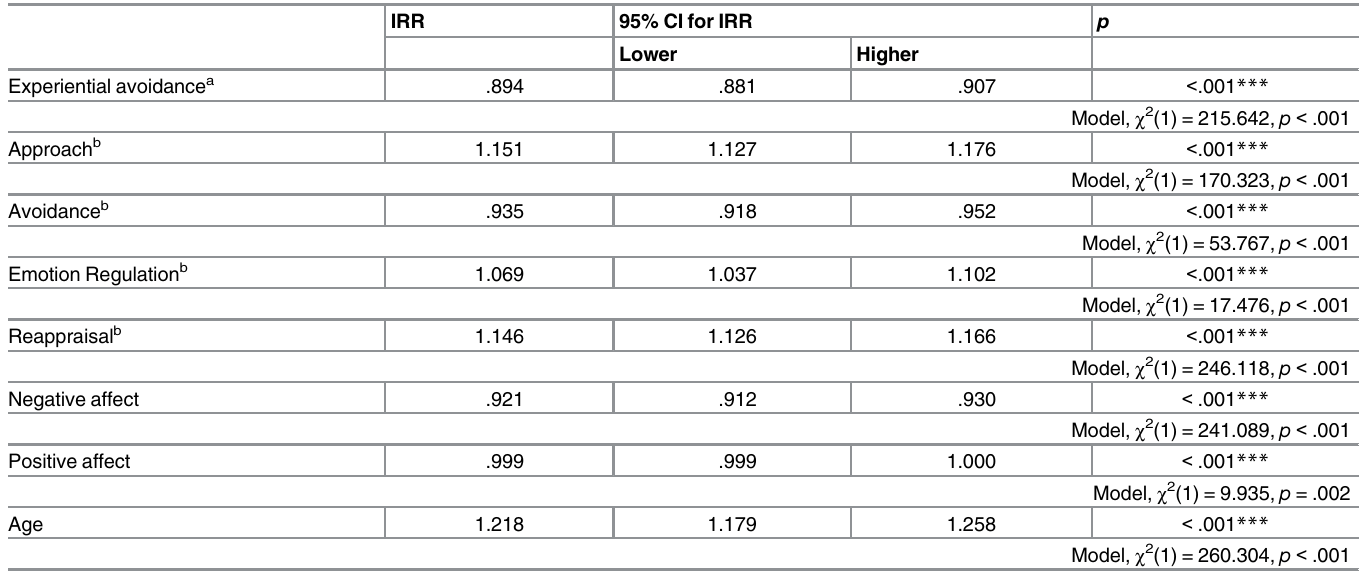
Table 5. A series of univariate negative binomial regression exploring whether functional coping dynamics and experiential avoidance predict self-harm recency ( n = 1173).